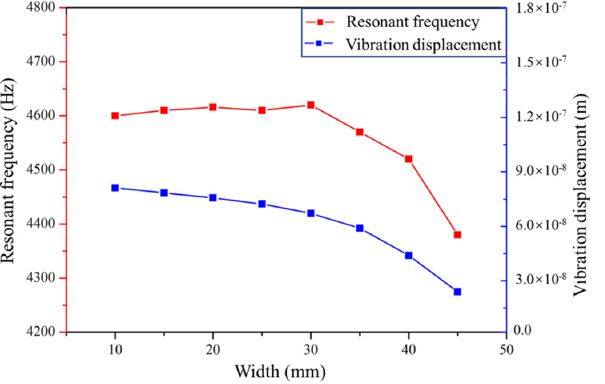
Figure 3. The curve of the resonance frequency and the maximum vibration displacement with width.